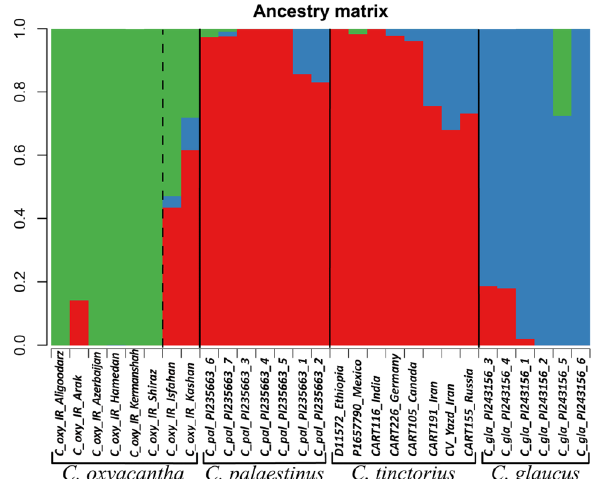
Figure 4. Population structure analysis based on 3720 unlinked SNP loci in LEA with K = 3 for C. oxyacantha , C. palaestinus , C. tinctorius and C. glaucus .